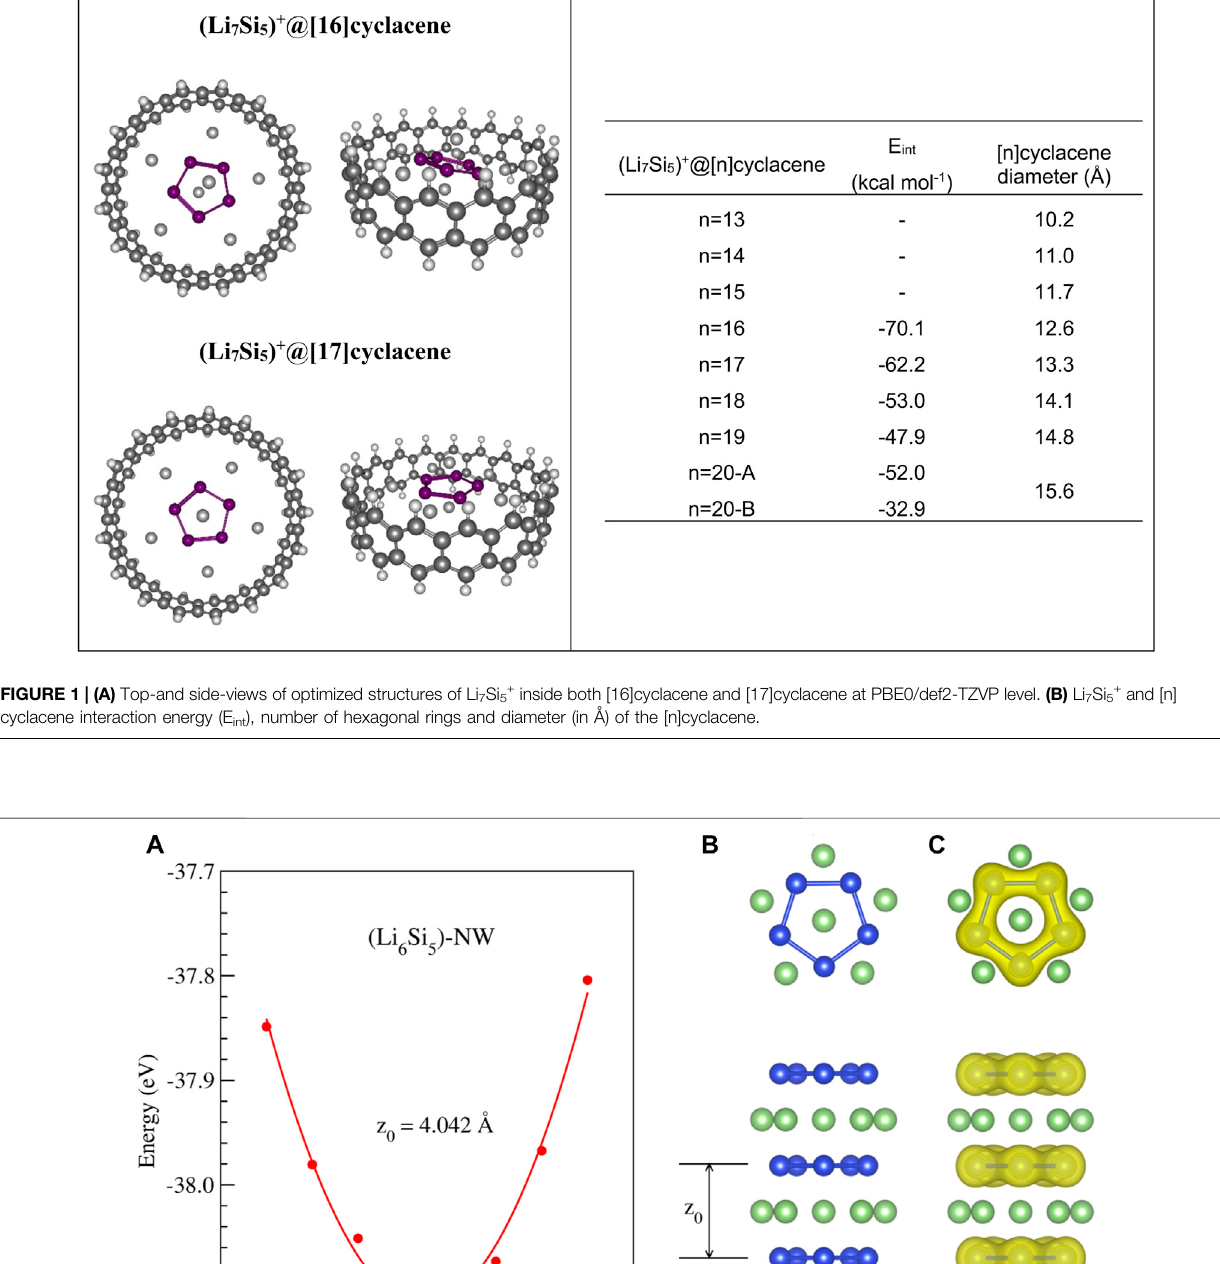
Frontiers in Chemistry |